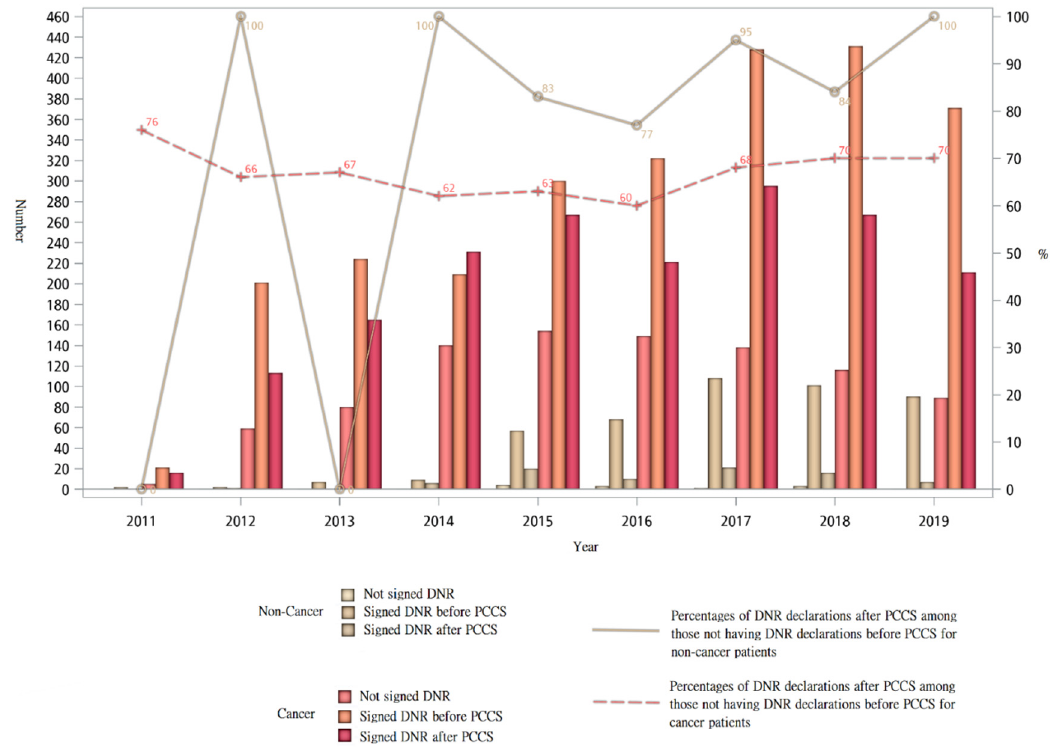
Figure 3. Trend of DNR declaration of terminally ill cancer and non-cancer patients receiving PCCS from 2011 to 2019.